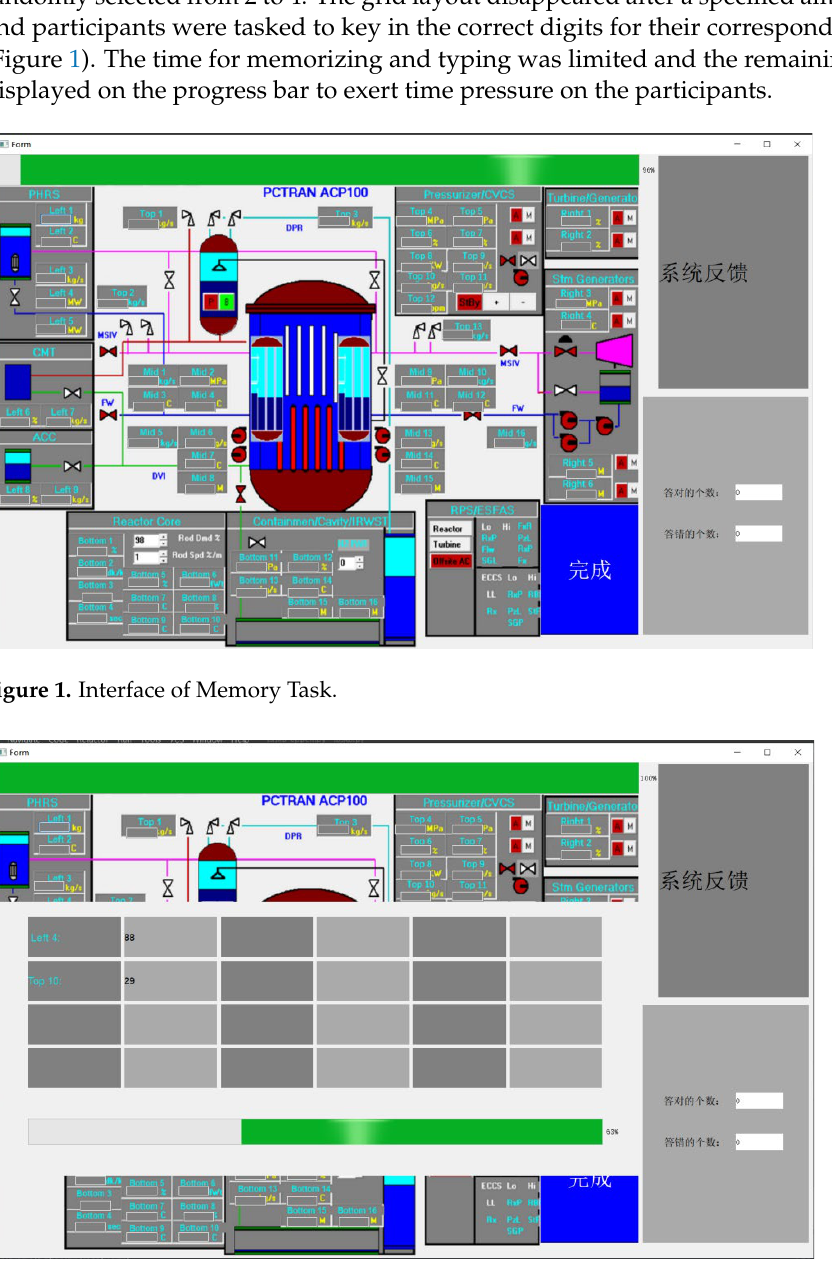
Figure 2. Initial Interface of Memory Task.